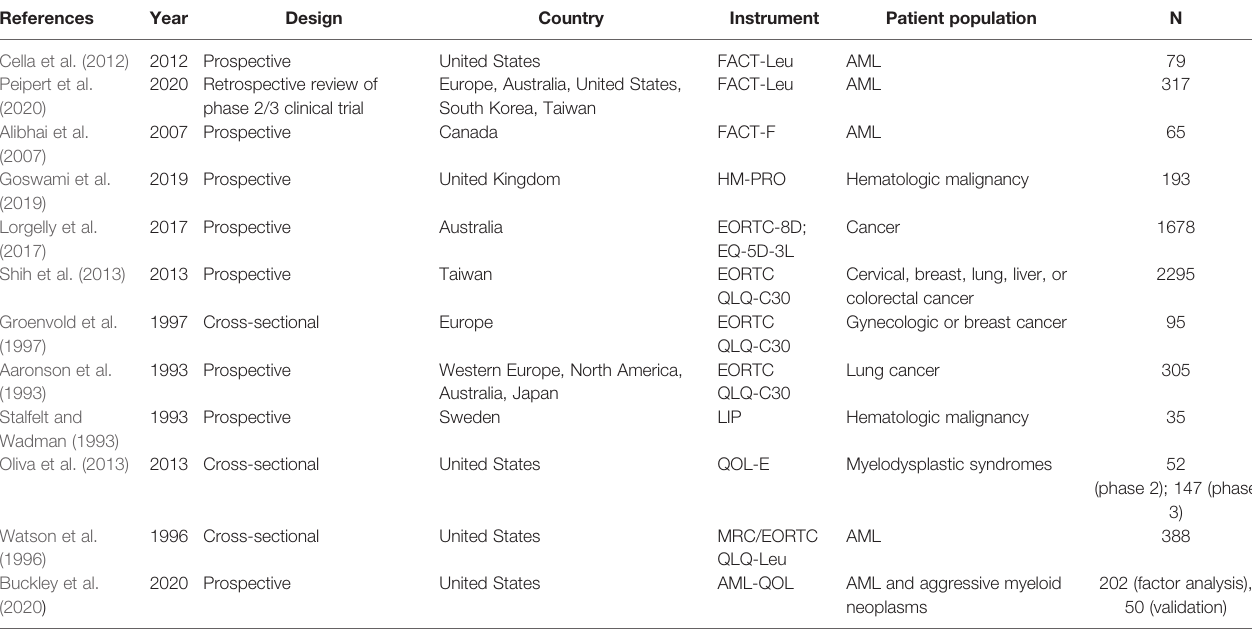
TABLE 1 | Description of included